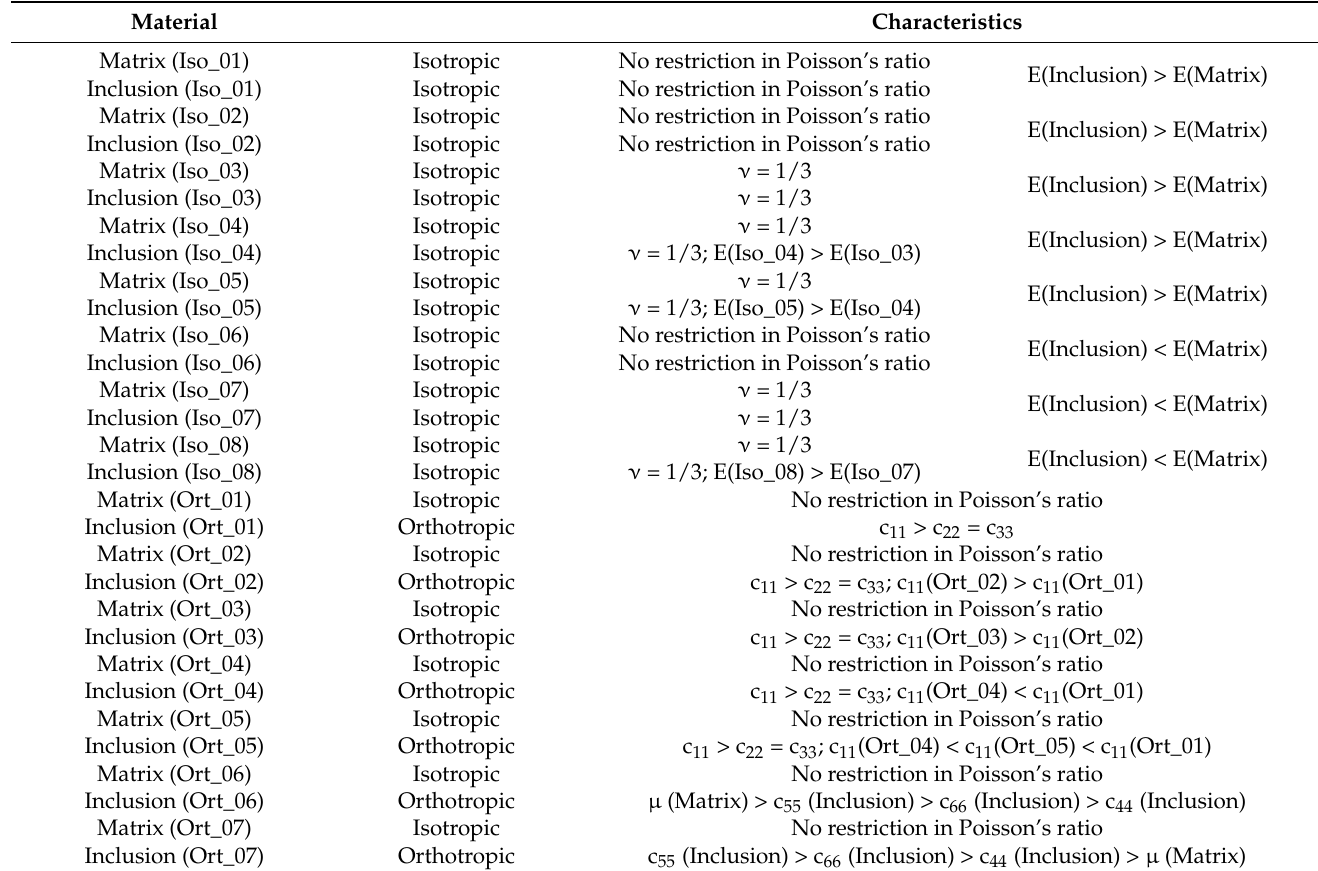
Table 5. Material Property Characteristics.